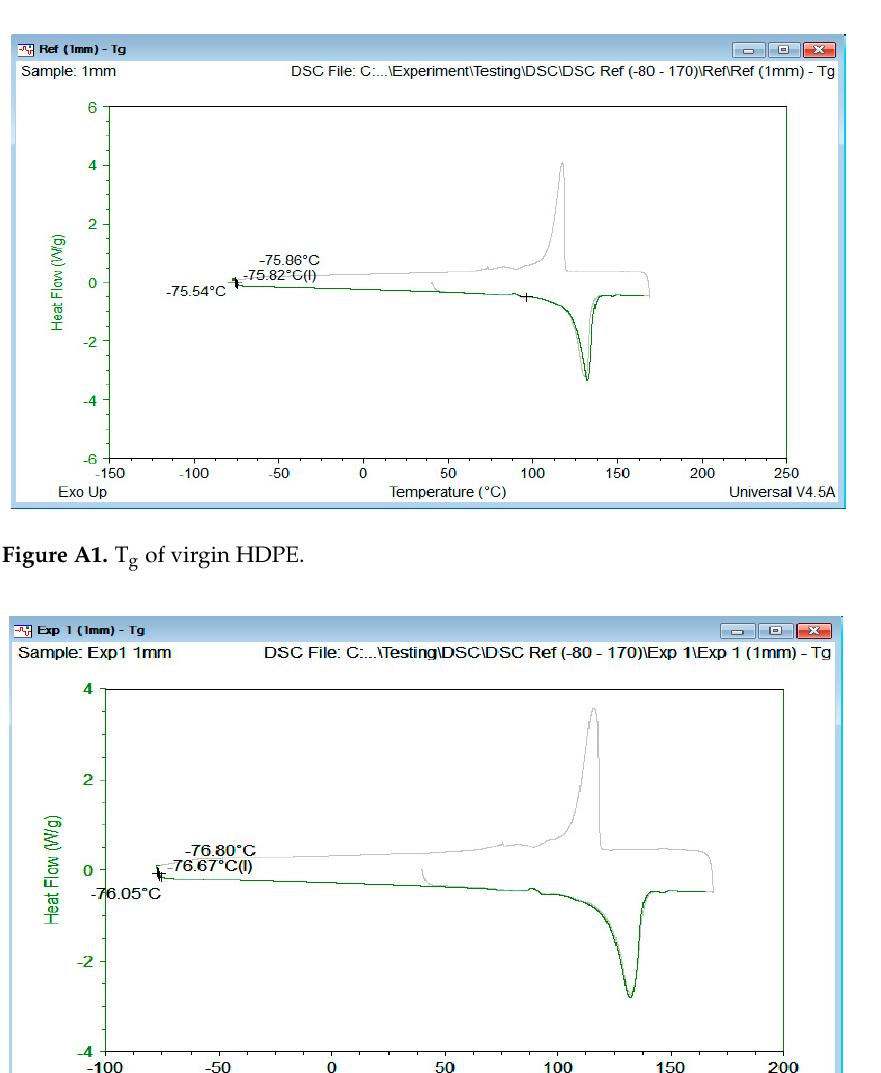
Figure A2. T g of HDPE after Experiment 1.